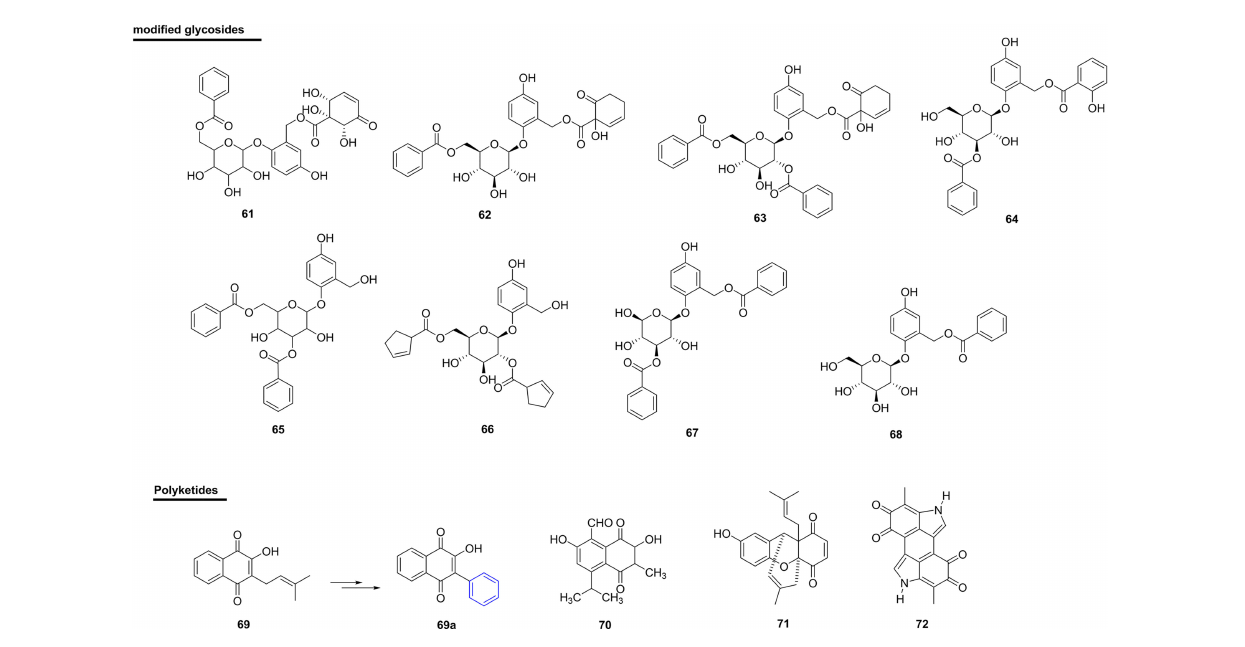
TABLE 4 | Modi fi ed glycosides (61-68) and polyketides (69-72) with antivenom properties. N° Compound Plant Activity